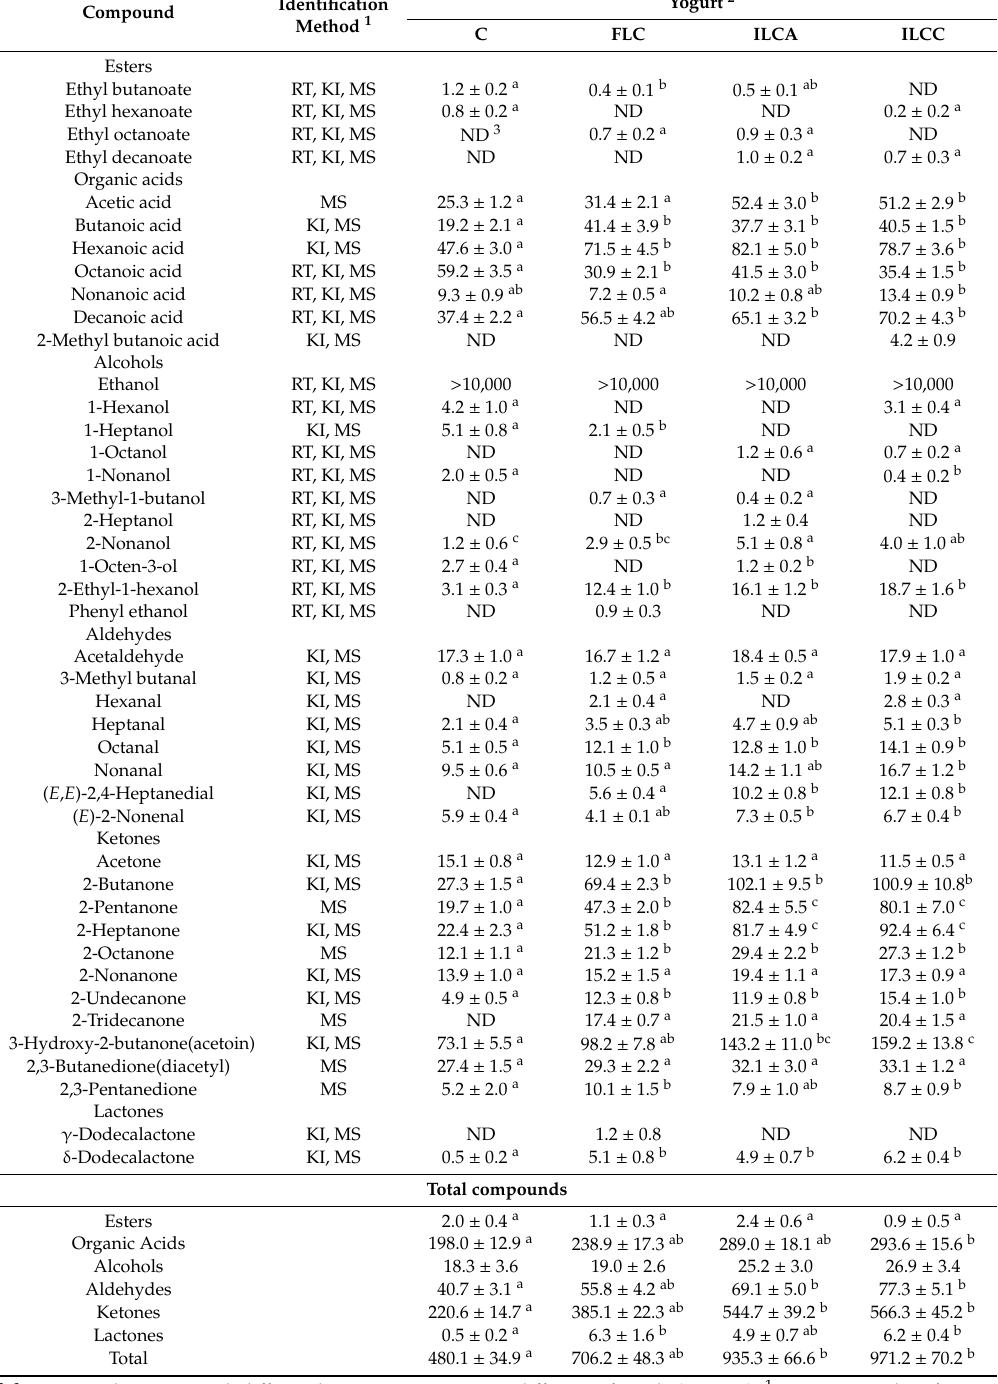
Table 2. Major aroma-related compounds ( µ g / kg) of novel probiotic yogurts after 14 days of refrigerated